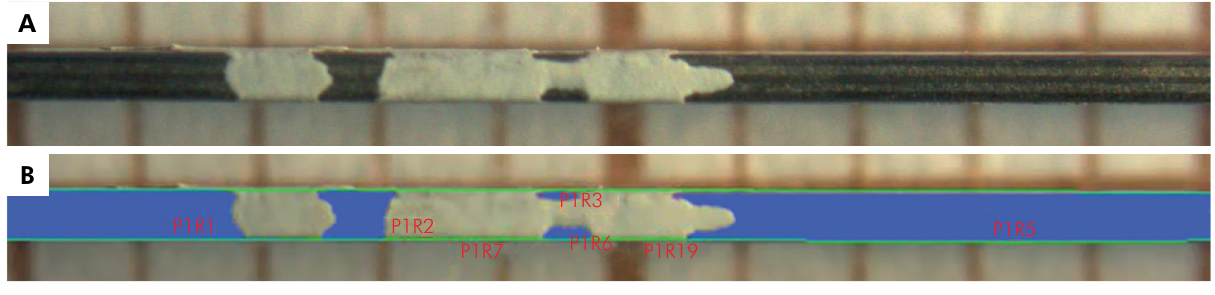
Figure 3. Stereomicroscope image of the labial surface of Titanol Cosmetic wire (10mm segment): A) before; and B) after the selection of coating loss area to be compared with the entire labial surface area. Original Magnification